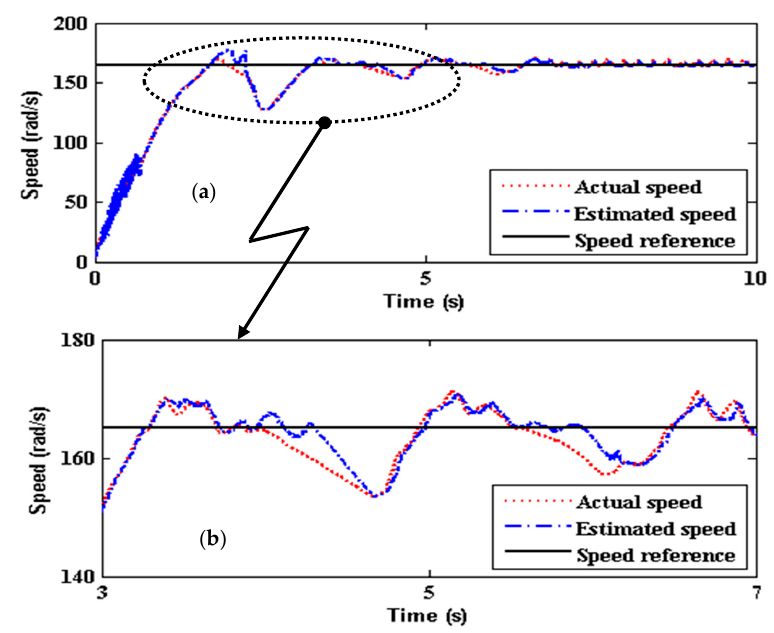
Figure 10. ( a ) Estimated speed of Modified Sliding Mode Luenberger Observer (SMLO 2); and ( b ) zoomed version of ( a ). Energies 2017 , 10 , 1077